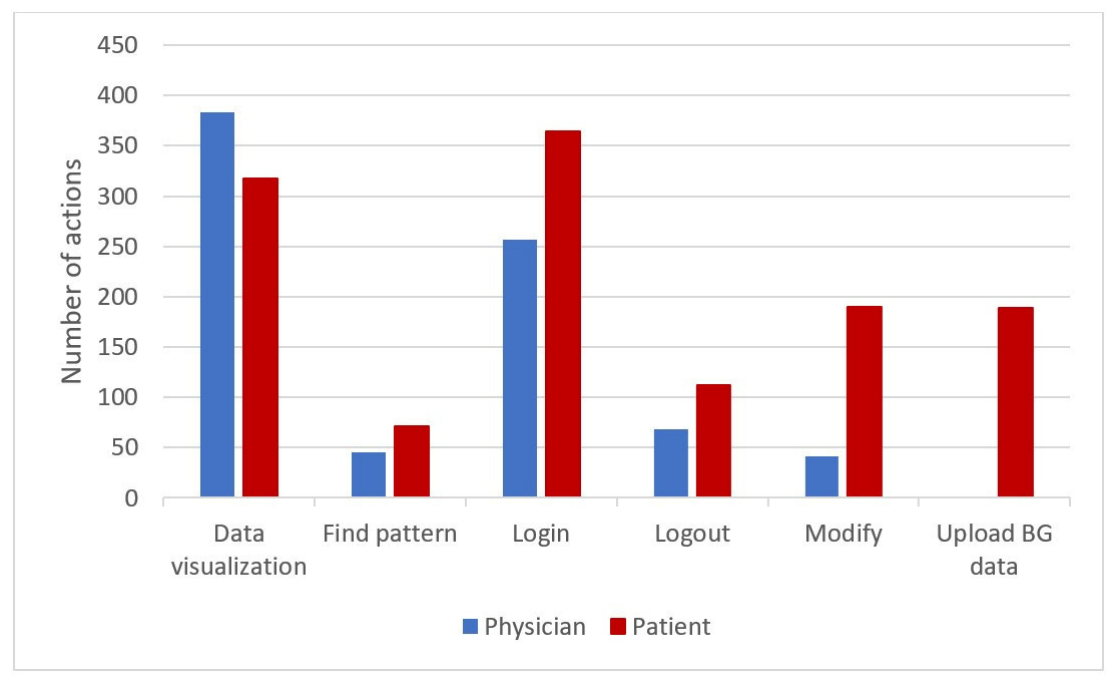
Figure 14. Frequency of actions performed by the AID-GM users in the pilot study. Figure 14 . Frequency of actions performed by the AID-GM users in the pilot study.